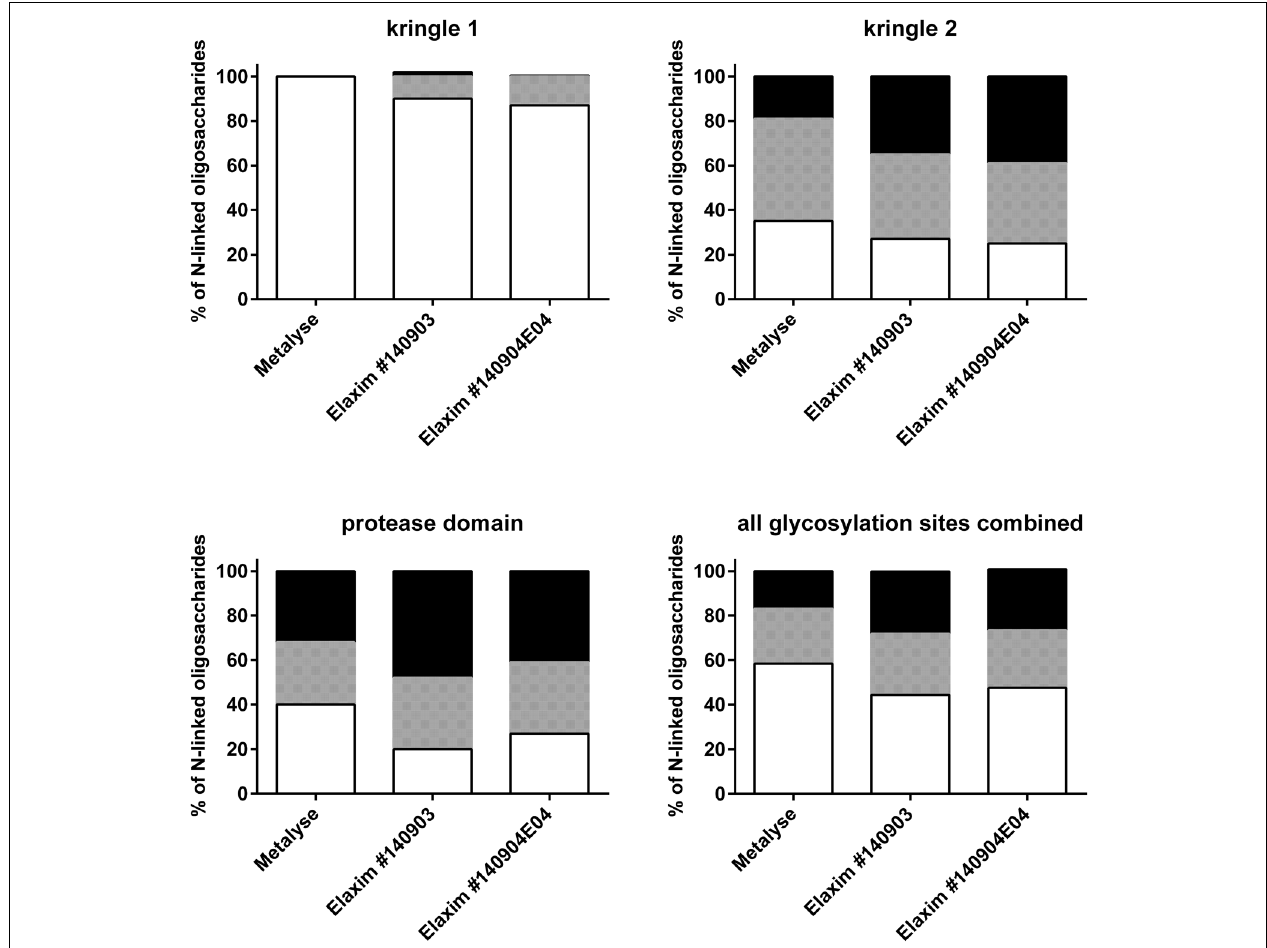
FIGURE 5 | Relative abundance of bi-, tri- and tetra-antennary N-linked oligosaccharides (indicated as white, grey, and black bars, respectively) at glycosylation sites in kringle 1, kringle 2, and protease domain and in the overall glycosylation sites .